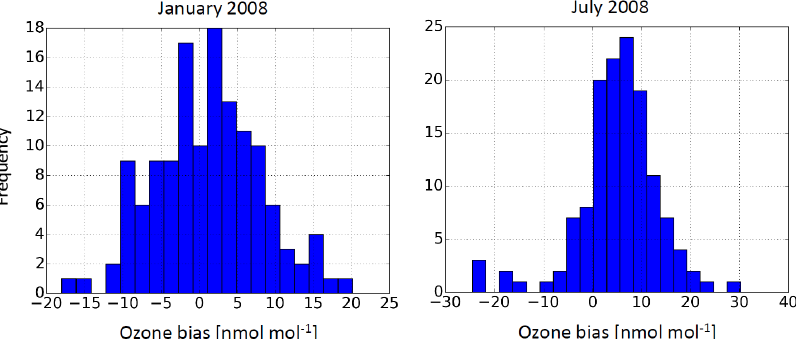
Figure 9. Monthly mean bias of surface ozone mixing ratios in January and July 2008 for all 5 ◦ × 5 ◦ grid boxes for which the TOAR database contains data in